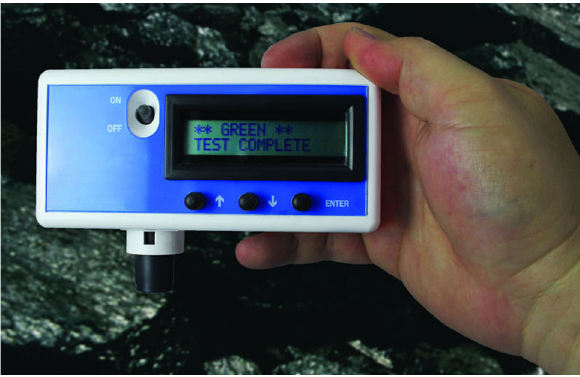
Fig. 7 NIOSH developed coal dust explosibility meter